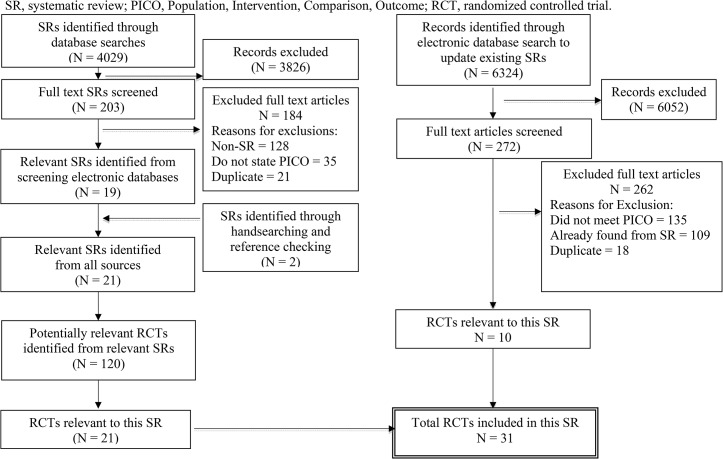
Flow diagram of study selection.SR, systematic review; PICO, Population, Intervention, Comparison, Outcome; RCT, randomized controlled trial.